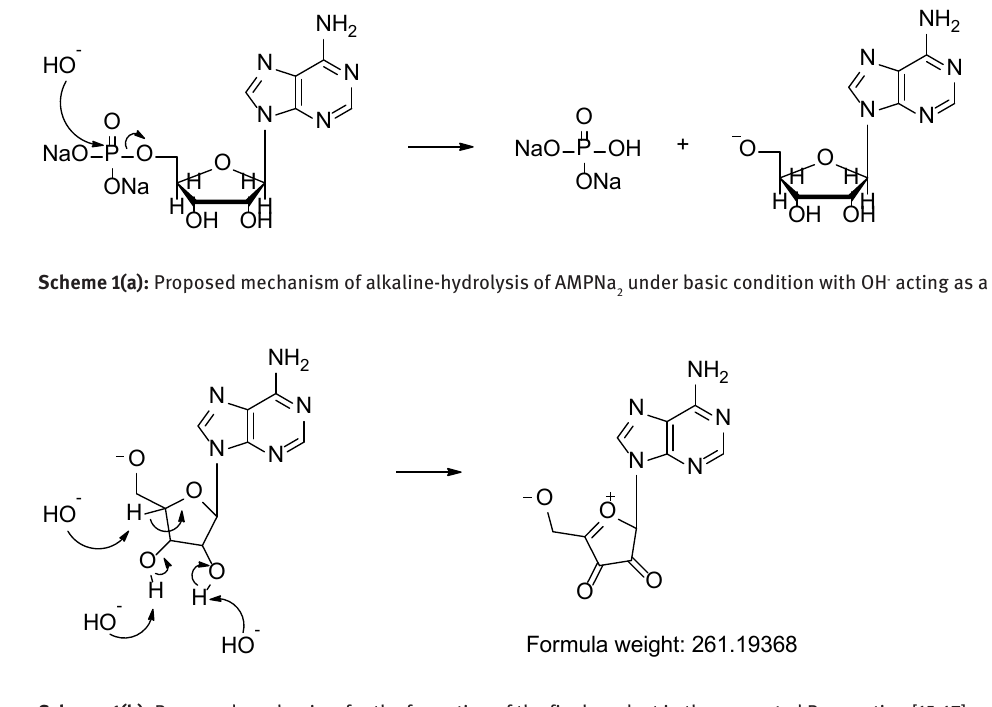
Figure 7: Positive-ion LC-MS spectrum of the final product of alkaline hydrolysis of 0.0001 M AMPNa